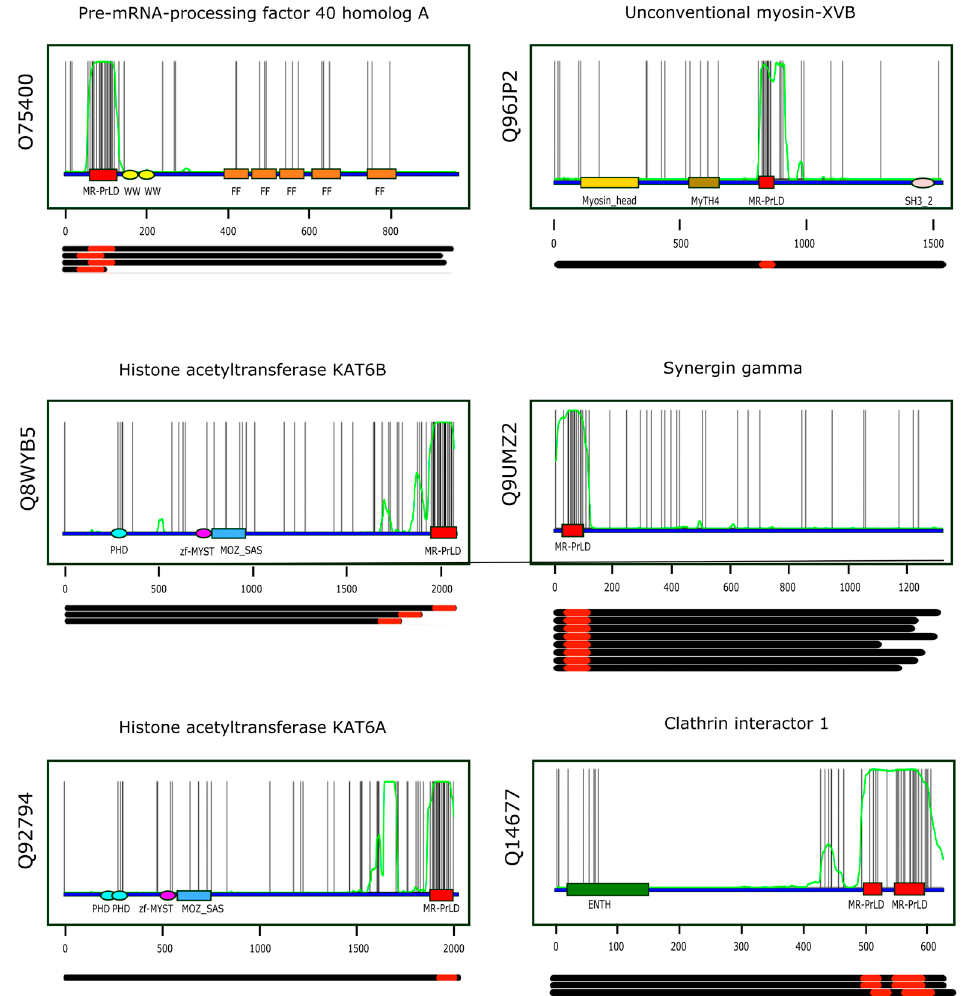
Figure 5. Multi-modular architecture of MR-PrLD-containing proteins. For the six top-ranking proteins in the MR-PrLD census (the Uniprot identifier is indicated vertically to the left of each plot, and the protein name horizontally at the top of each plot), the positions of the methionine residues along the primary structure are represented by black vertical lines. Along the protein sequence (blue segment), we have marked the Pfam domains detected in each protein using colored rectangles and ellipses. The MR-PrLDs are represented as red boxes. The green curve represents the probability of the residue at that position being part of a PrLD according to PLAAC [33], an algorithm based on hidden-Markov models. Each plot has been done using the canonical form of the protein being analyzed. Below each plot, the length of the different isoforms known to be produced by alternative splicing are represented as black segments, and their MR-PrLDs as red rectangles.